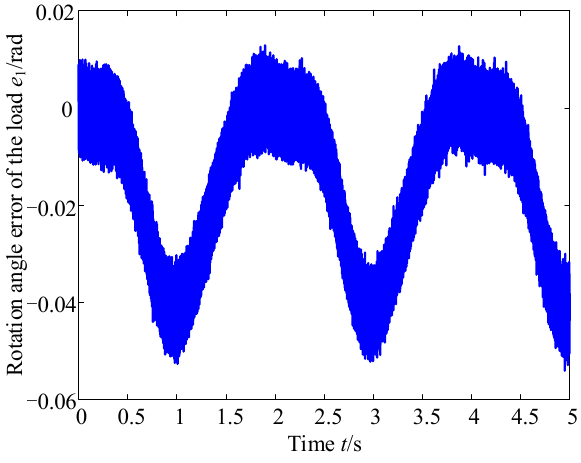
Figure 12. Experimental error.